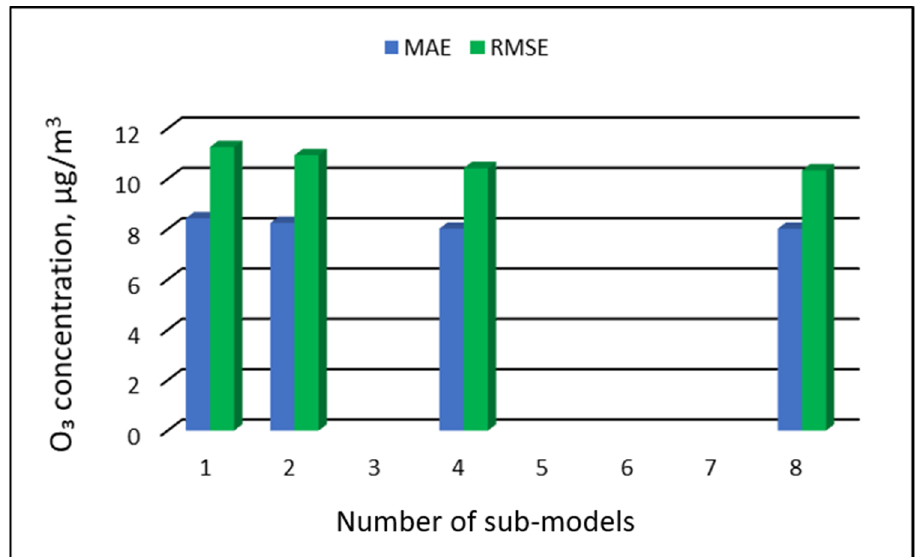
Figure 5. Overall MAE and RMSE values for O 3 concentration prediction in PVS models depending on the number of created sub-models, Zabrze. Table 4. Values of approximation errors of O 3 concentrations in PVS models, Z ł oty Potok 2011–2016.